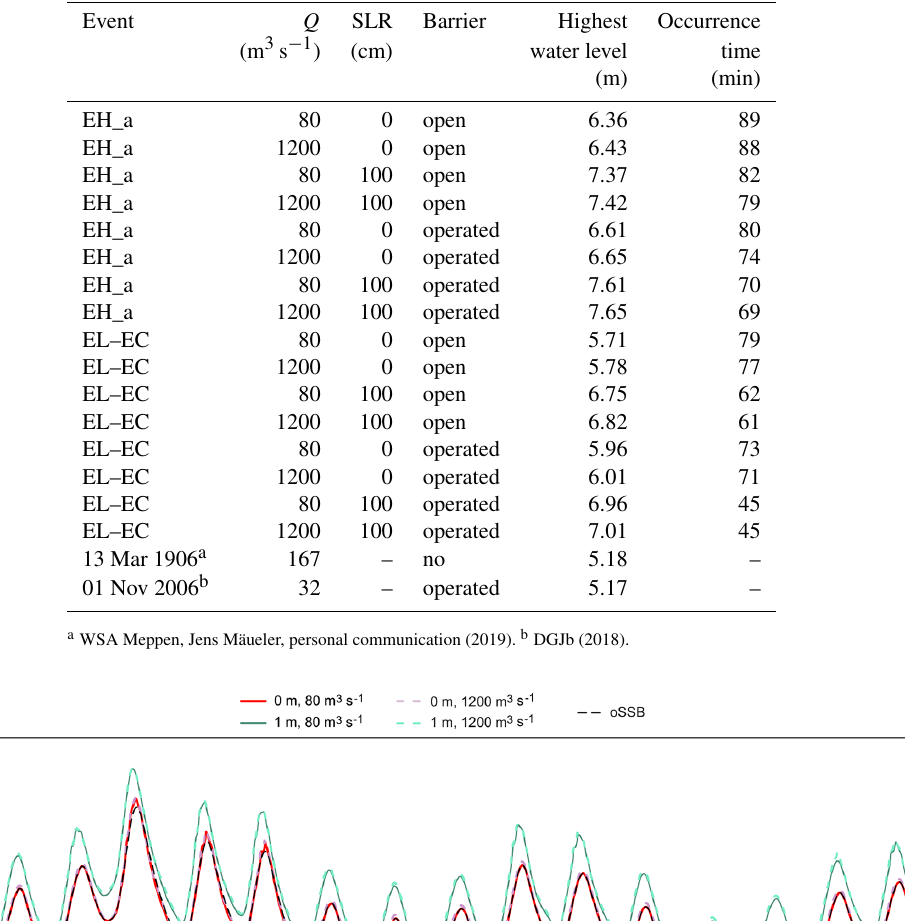
Table 1. Highest water levels and their occurrence times at Emden are given for simulations with varying river runoff Q , sea level rise SLR and modes of operation for the storm surge barrier. The occurrence time of the highest water level is given relative to the Ems kilometre 107 (Hubertgat).